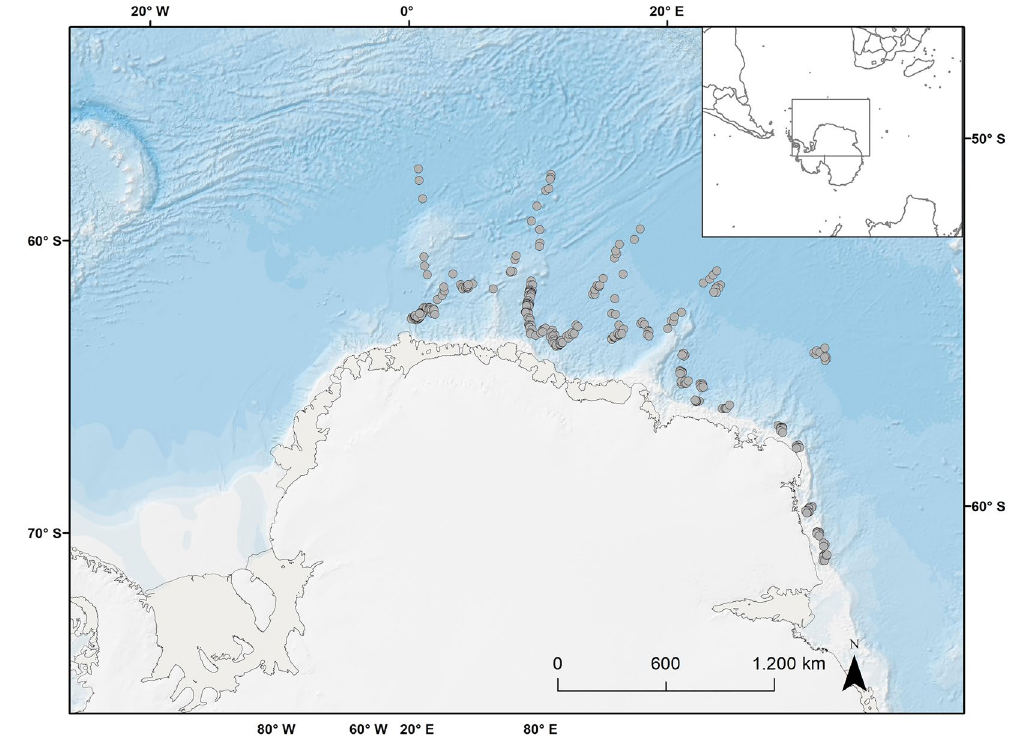
Figure 1. Study area. Gray dots indicate the location of each of the 333 Antarctic minke whales, Balaenoptera bonaerensis , captured in the Southern Ocean between December 2018 and February 2019. Figure generated with ArcGIS (version